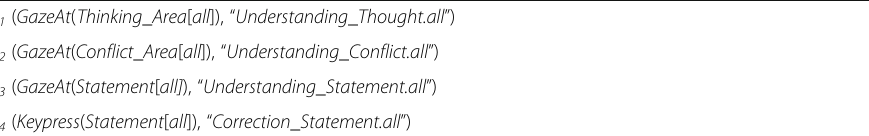
Table 3 Lower-level interpretation rules